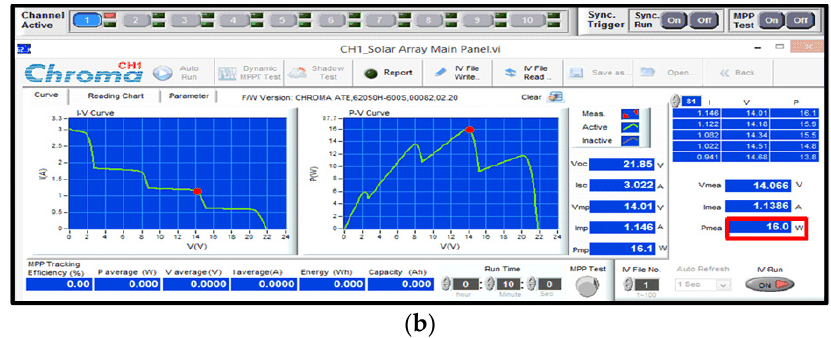
Figure 25. Experimental result under PSC 3 of the proposed modified LFO, ( a ), ( b ) reflect same result.